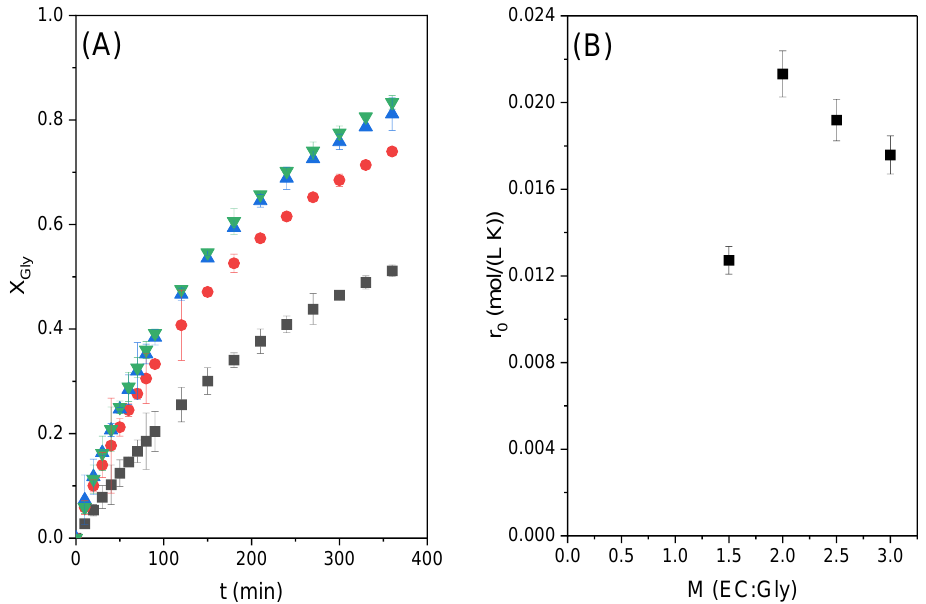
Figure 4. ( A ) Effect of the initial molar ratio of reactants at 80 ◦ C with 3% catalyst loading. In this subfigure the glycerol conversion is presented as a function of reaction time with the CE/Gly ratio (M), where ◼ M = 1.5; ⚫ M = 2; M = 2.5; and M = 3. ( B ) Effect on the initial reaction rate due to the initial CE/Gly molar ratio.